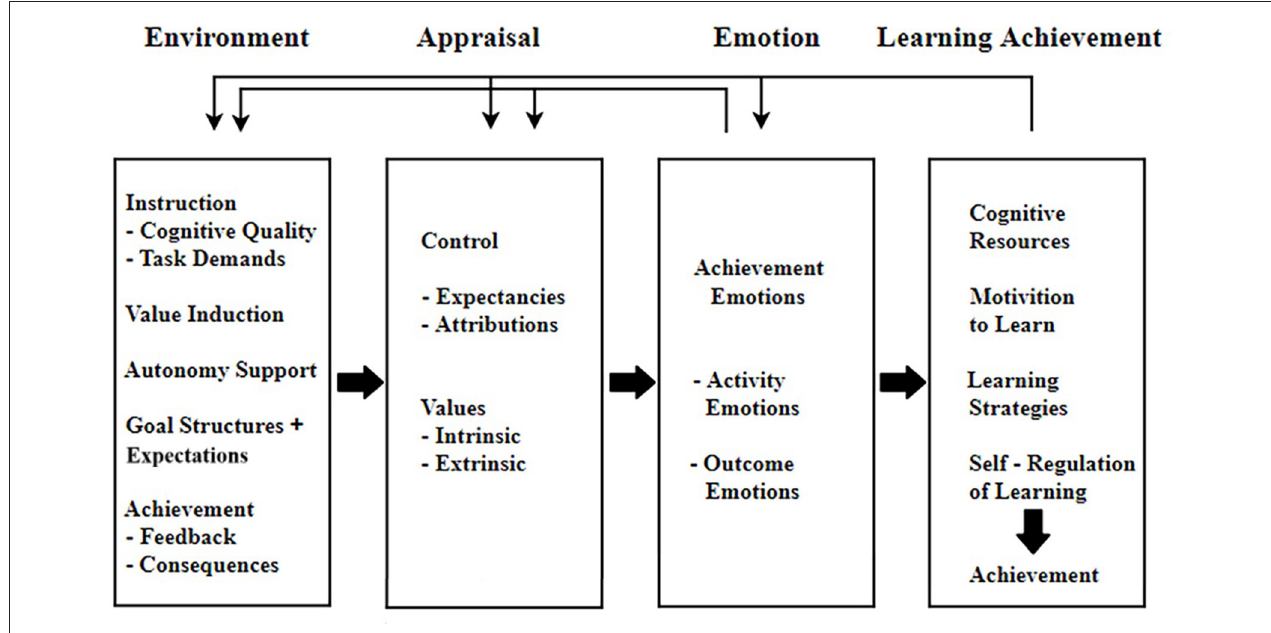
FIGURE 1 | The control-value theory (partial) (Pekrun, 2006).